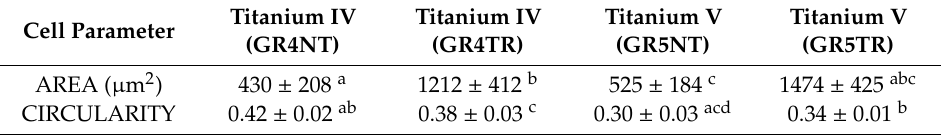
Table 2. Cell area and circularity values obtained on the four surfaces analysed.